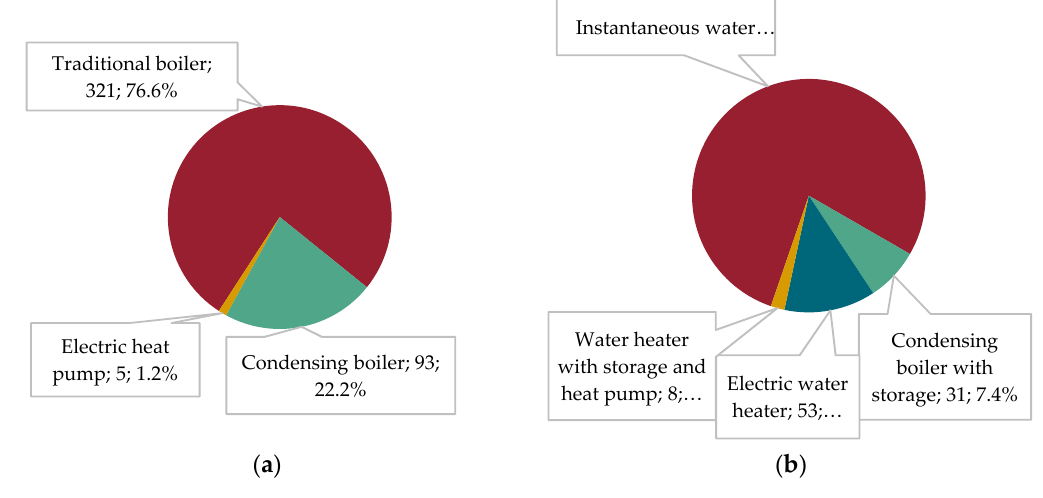
Figure 2. Types of heating systems: ( a ) space heating; ( b ) DHW.